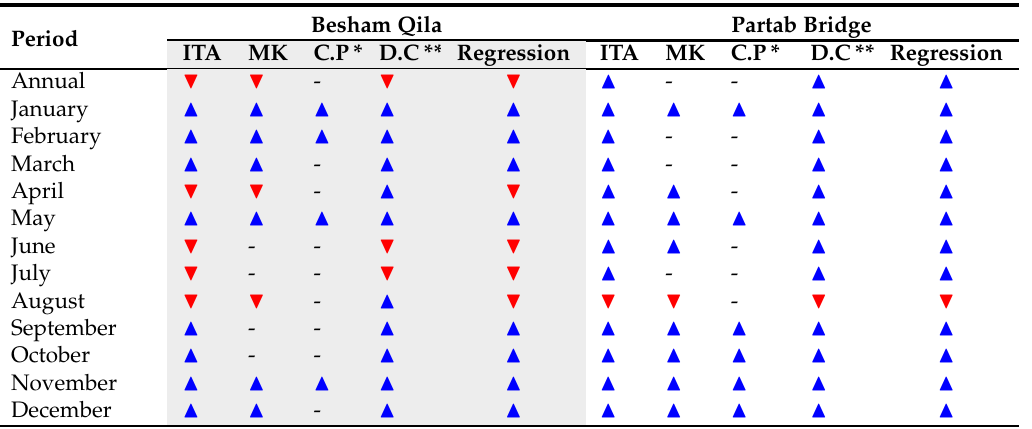
Table 7. Qualitative comparison of the trends in SSLs using different methods (blue triangles imply an upward trend, whereas red triangles imply a downward trend; a “-” represents statistically insignificant/no trend). ITA, innovative trend